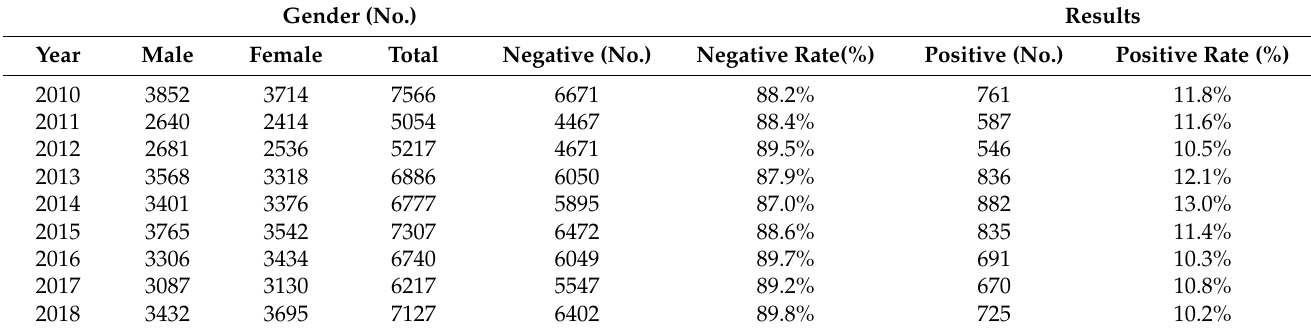
Table 1. The number of men and women in each year and the inspection results.